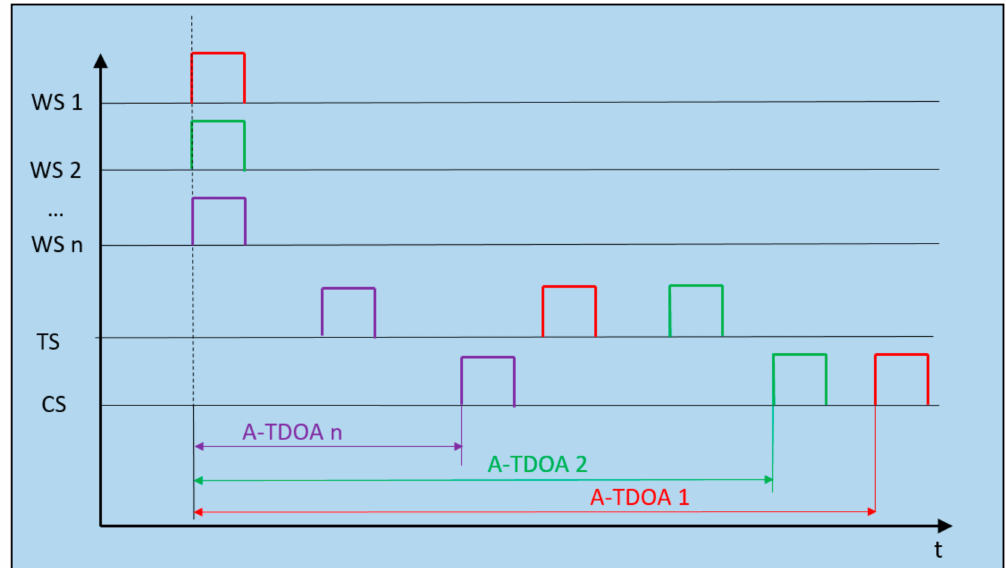
Figure 1. Asynchronous Time Difference of Arrival (A-TDOA) system timing diagram. Example of architecture operation with n Worker sensors (WS) nodes ( n must be at least equal to 4). Rectangular positioning pulses are emitted from the WS nodes, and when the arrival of the signal to the Target Sensor (TS) node is produced, signals are instantaneously retransmitted to the